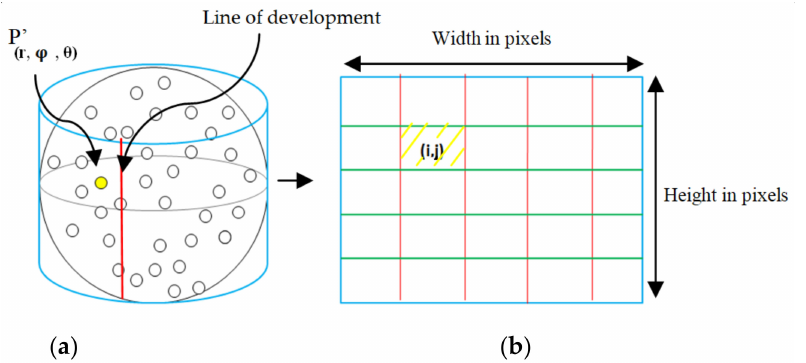
Figure 4. ( a ) Schema of the equirectangular cylindrical projection; ( b ) schema of the panoramic image after developing the cylinder (the parallel lines of the sphere are in green and the meridians in red). The panoramic image has been correctly generated; thus, the process is validated.